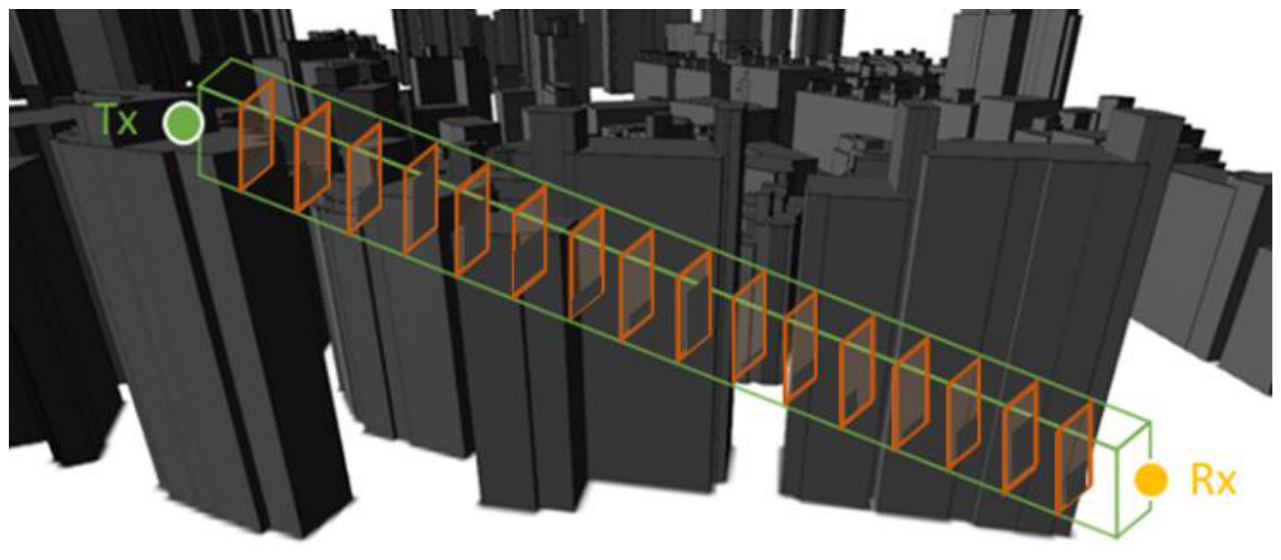
Figure 1. 3D-LAMS Pseudo Image.